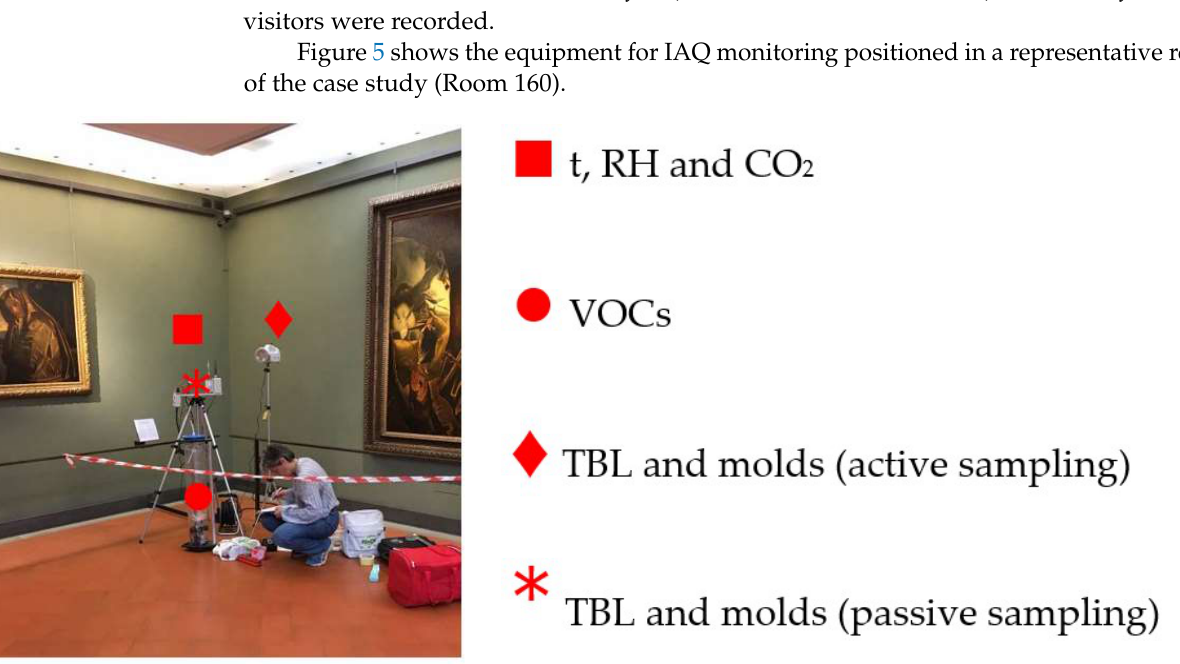
Figure 5. Equipment for IAQ monitoring positioned in a representative room of the Uffizi Gallery (Room 160).